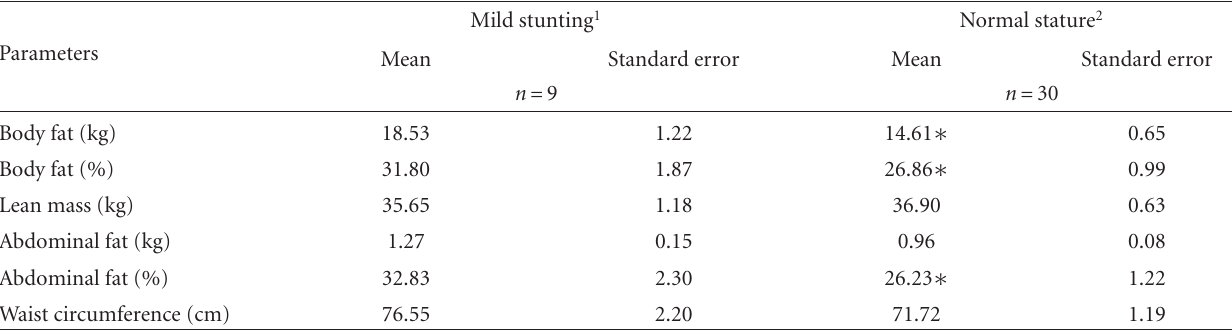
Table 4: Body composition of the study